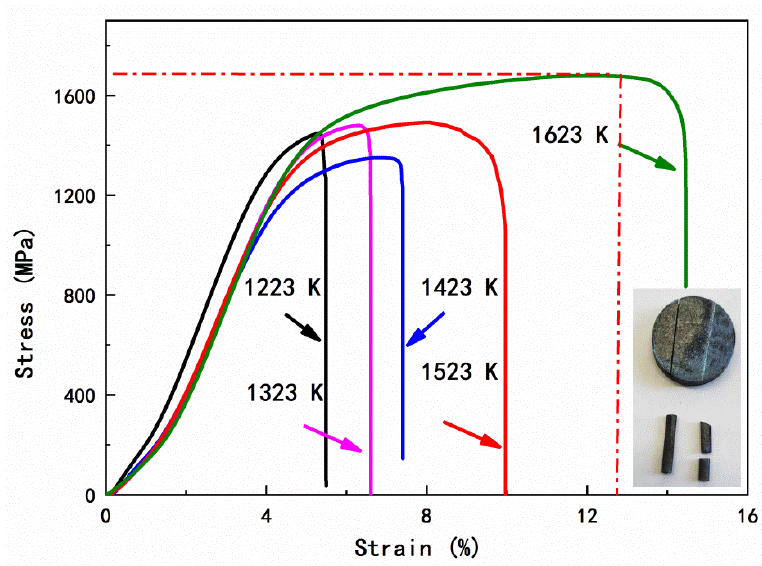
Figure 4. Compressive engineering stress–strain curves for samples sintered at different temperatures. Table 2. The compression properties of Ti-25Nb-6Zr alloy at different temperatures. Temperature (K)